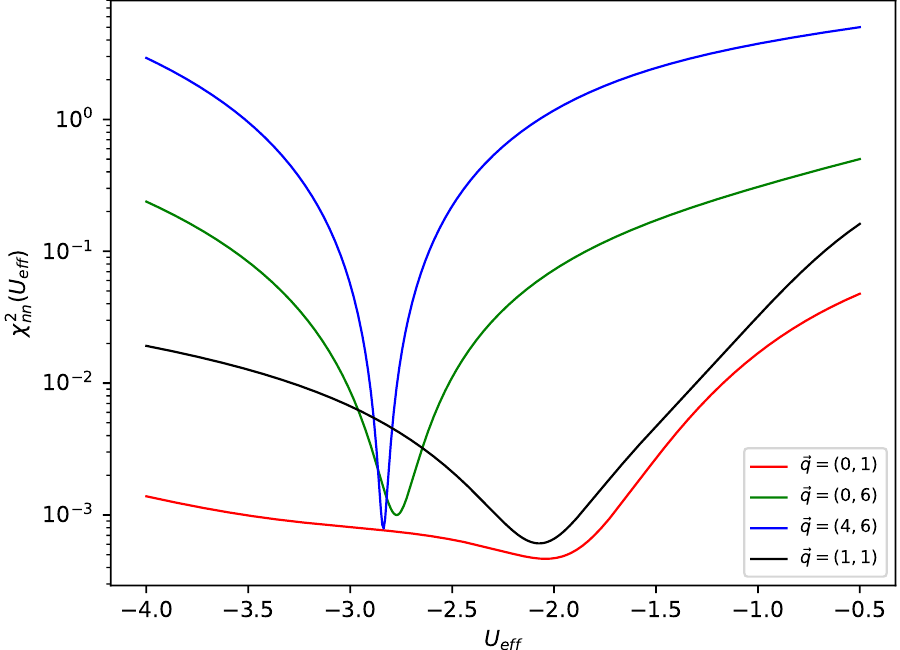
Figure 3. X 2 nn ( U ef f ) , the chi-squared factor comparing the AFQMC and GRPA results for the density– density intermediate scattering function, expressed as a function of the effective potential U ef f . Results are given for the momenta used in Figure